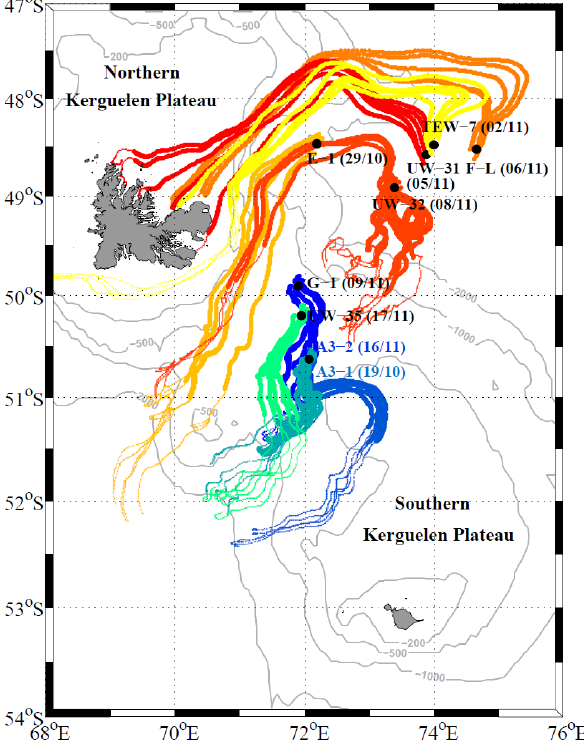
Figure 9. Lagrangian particle analysis derived from total surface currents (considering absolute geostrophic plus Ekman currents). Solid circles represent the location of the stations. The targets for Lagrangian analysis were centered on and around the station loca- tions (to account for spatial variability). The sampling date is indi- cated in parentheses. Two-month backward trajectories are shown. The first month of the backward trajectory is represented by a thick line. The second month of the backward trajectory is represented by a thinner